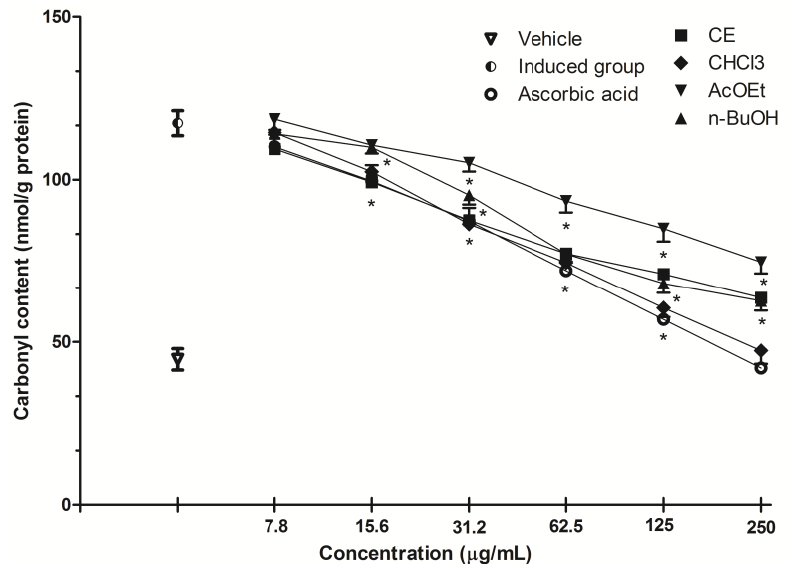
Figure 4. Effect of S. guaraniticum CE and fractions on protein carbonyl content in serum samples.